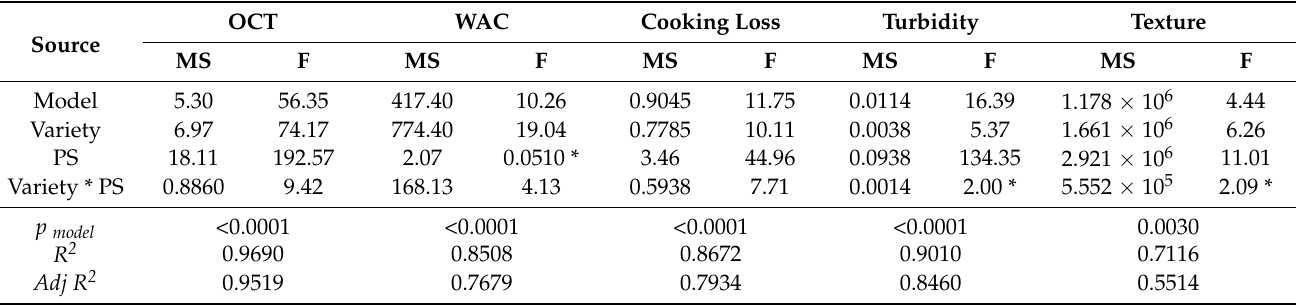
Table 1. Two-way ANOVA data and Fisher’s F-statistic values for different quality attributes of udon noodles with respect to the wheat variety and amount of porous starch